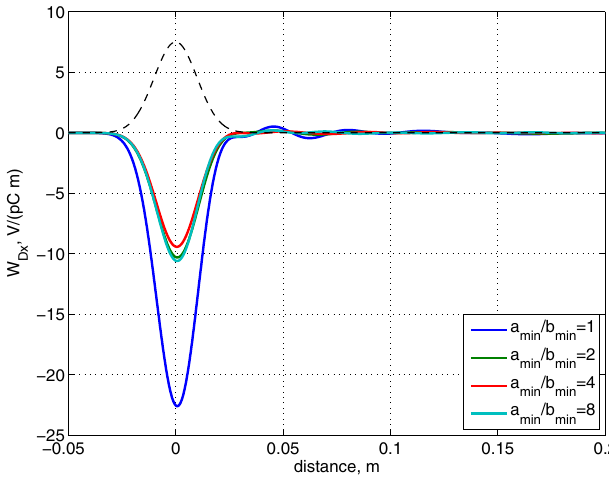
FIG. 2. (Color) Dipolar-horizontal wake potentials (solid line) and beam density (dashed